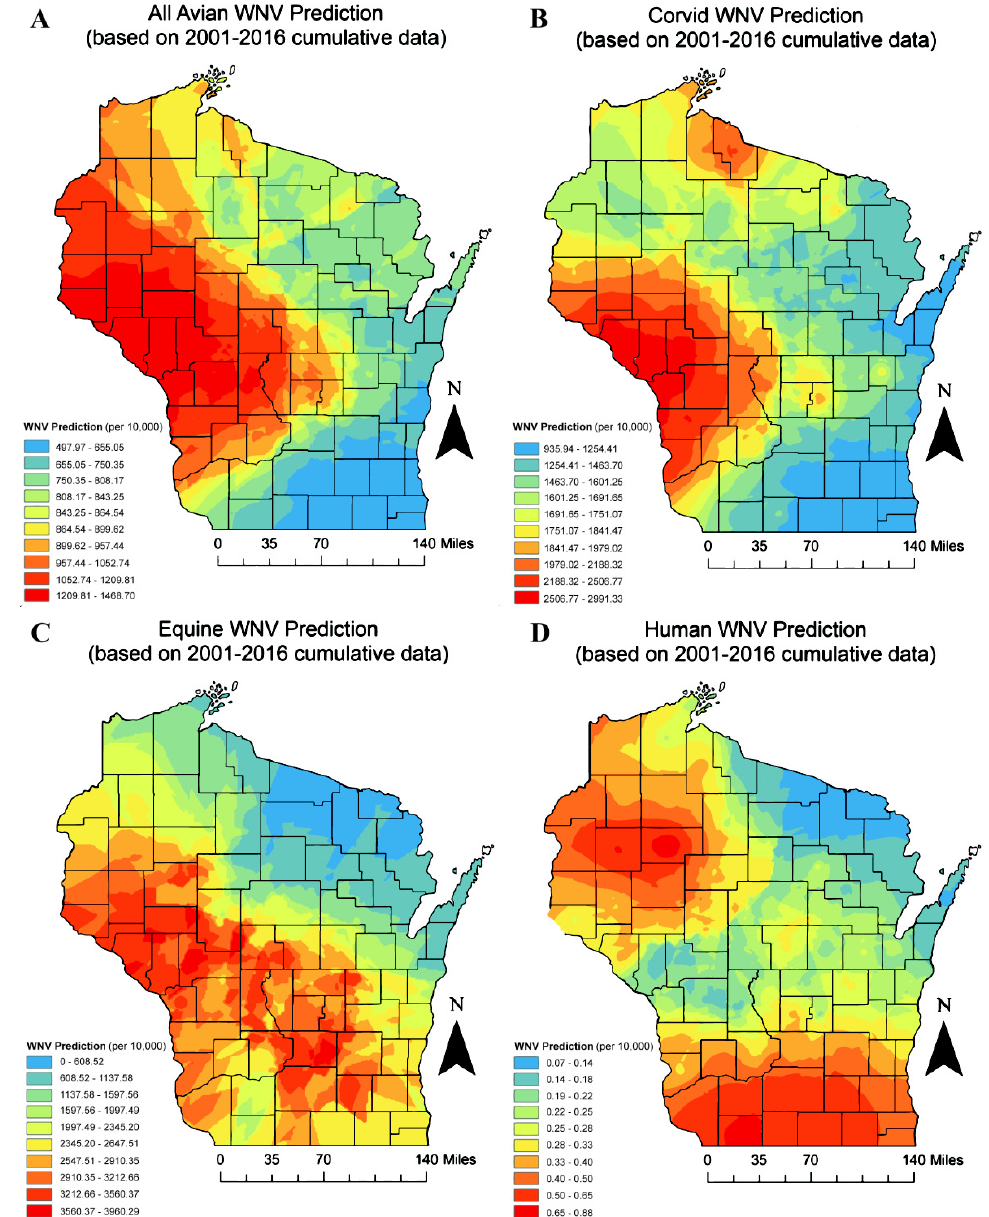
Figure 4. Wisconsin WNV prediction maps by all avian cases ( A ), corvids ( B ), equines ( C ), and humans ( D ) (Empirical Bayesian kriging method) based on cumulative (2001–2016) case data. Color values indicate predicted WNV cases per individual species.